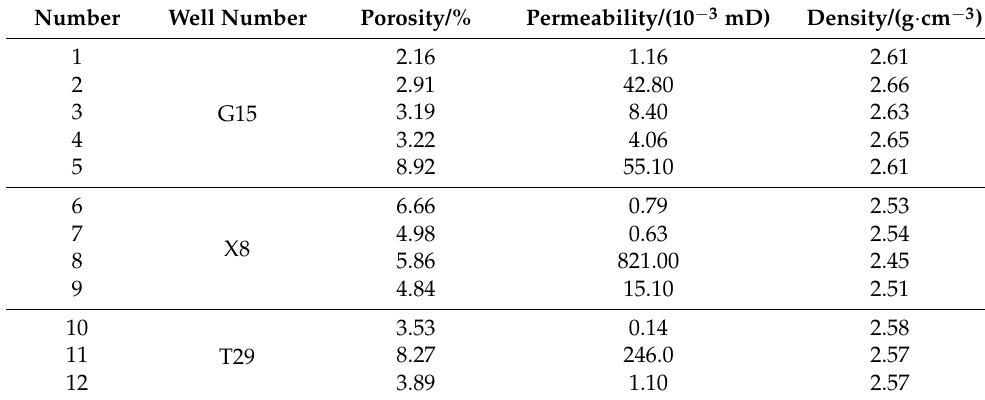
Table 10. Laboratory results of porosity and permeability characteristics of caprock samples of the adjacent